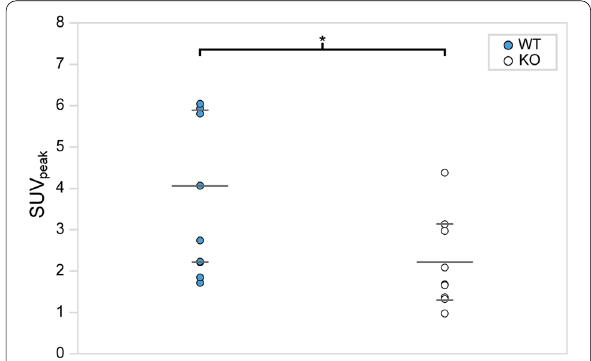
Fig. 6 [ 18 F]FDG SUV peak within interscapular BAT of fasted male mice after NE injection. SUV peak is plotted for each genotype. Means (short) and standard deviations (long) for each group are represented by horizontal gray bars. With fasting, a statistically significant difference between male WT (blue) and KO (white) SUV peak was observed ( p 0.03). However, the WT and KO SUV peak ranges still overlapped = and a clear SUV threshold to differentiate animals with very different thermogenic capacity cannot be established, despite animal